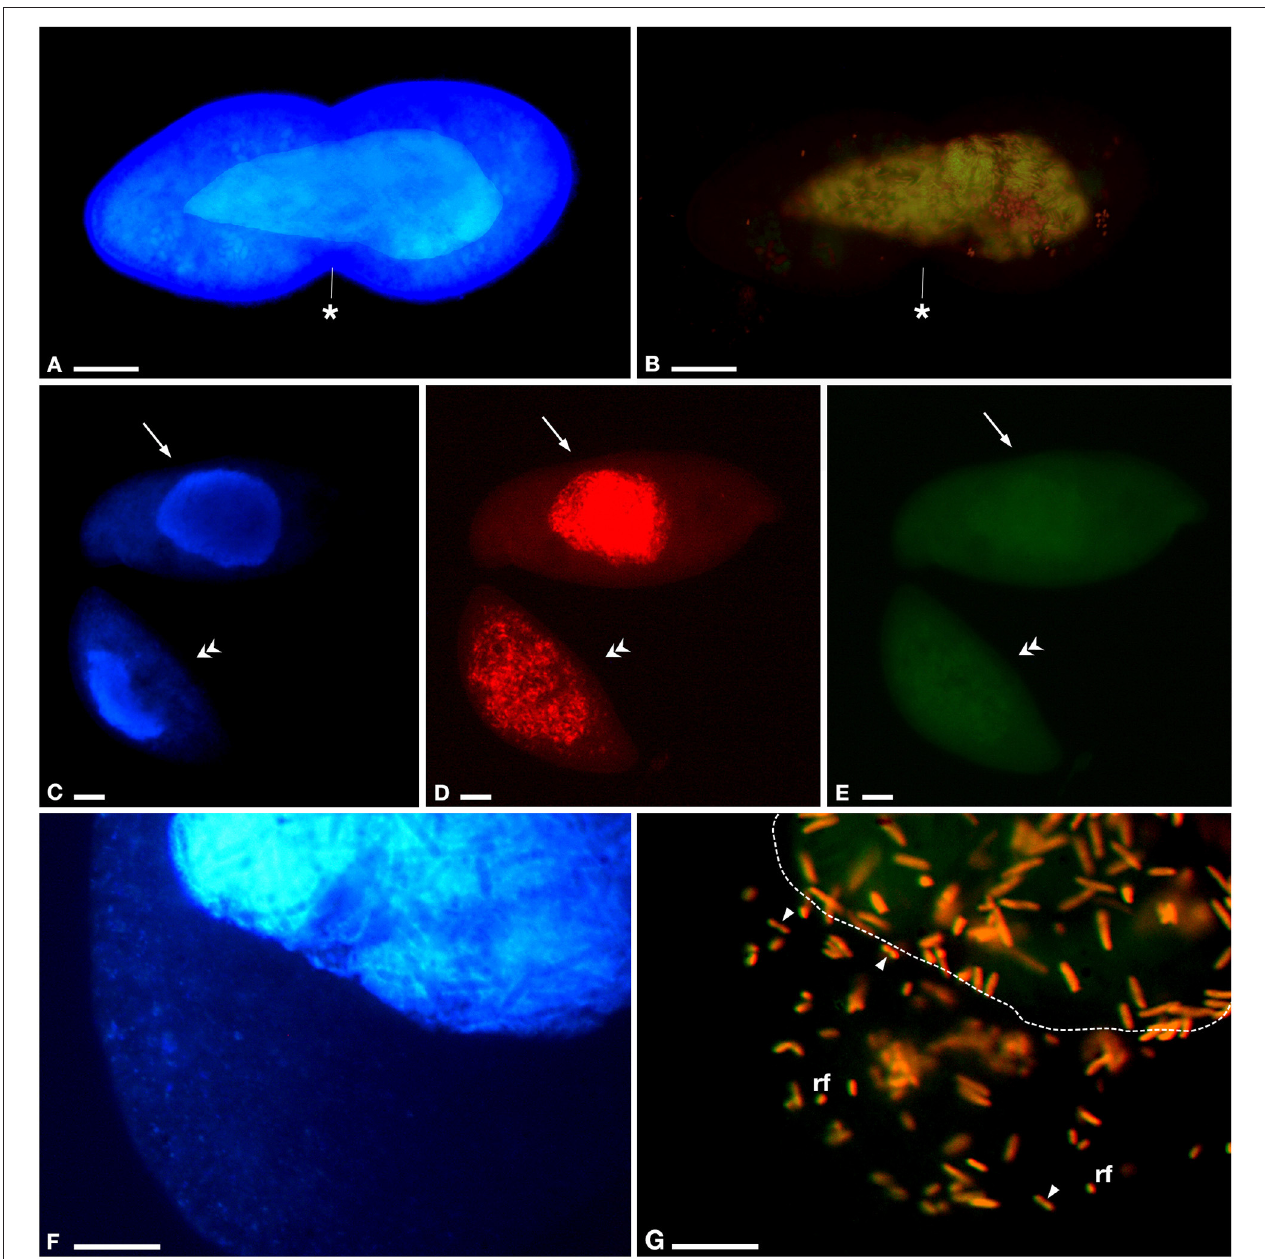
FIGURE 5 | Results of fluorescence in situ hybridization (FISH) on P. multimicronucleatum TP2. Experiments were performed with different probe combinations: (A,B) GortProb659 (“ Ca. Gortzia” genus-specific) and EUB338 ( Bacteria ), (C-E) GortzSha_1266 (“ Ca. Gortzia shahrazadis” species-specific) and GortzInf_1268 (“ Ca. Gortzia infectiva” species-specific), (F,G) GortzSha_1266 and EUB338. (A) Cell in division with infected macronucleus ( ma ), stained with 4,6-diamidino-2-phenylindole (DAPI), (B) positive to GortProb659 and EUB338 probes, completely overlapping. (C) Two cells fixed after 1year of culturing, showing intact ma stained with DAPI, (D) positive to GortzSha_1266, in ma (upper cell) and also in cytoplasm (lower cell), (E) same cells are negative to GortzInf_1268. (F) Closer view of cytoplasm and part of ma stained with DAPI of a P. multimicronucleatum cell infected by bacteria, (G) which are positive to GortzSha_1266 and EUB338 probes, with completely overlapped signals: reproductive forms ( rf ) and infectious forms well visible in host cytoplasm. Arrows indicate host cell with infection restricted to ma only, double arrowheads host cell with infection both in ma and in cytoplasm; arrowheads endosymbiont reproductive forms in cytoplasm during binary fission; dotted line position of ma inside host cell. The asterisks indicate the cleavage furrow. Bars stand for 20 µ m (A–E) and 10 µ m (F,G) . was their membrane composition: in the majority of IF the periplasm, interposed with other cytoplasmic regions (probably surface membrane was surrounded by fine fibrous material forming the striped/dotted pattern previously observed via and, in some cases, manifests an additional membrane covering DIC microscopy). Another difference between IF and RF